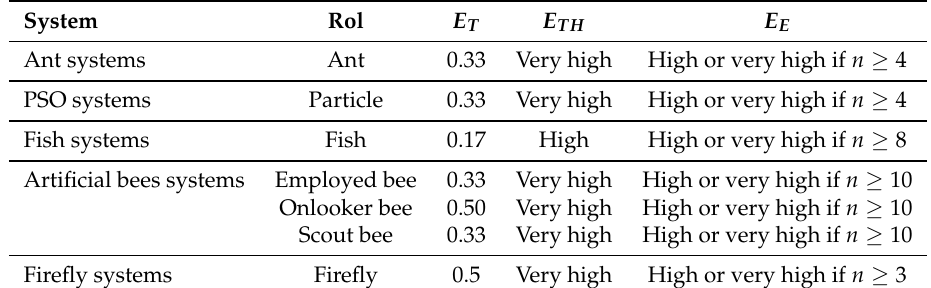
Table 3. Measure of specialisation in several systems ( E T : Degree of specialisation of tasks; E TH : Degree of specialisation of horizontal tasks; E E : Degree of corporate specialisation; n : Number of individuals or